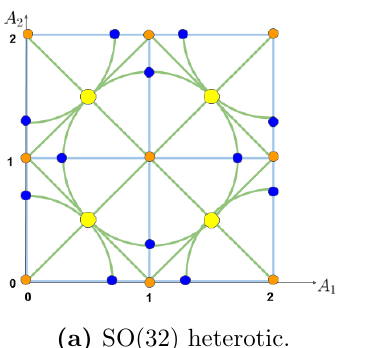
(a) SO(32) heterotic. Figure 3. Enhancement groups on the left sector of the heterotic theory on the slice of moduli space de(cid:12)ned by A 3 ;:::; 16 = 0, R 2 = 3 = 4. See table 3 for details.